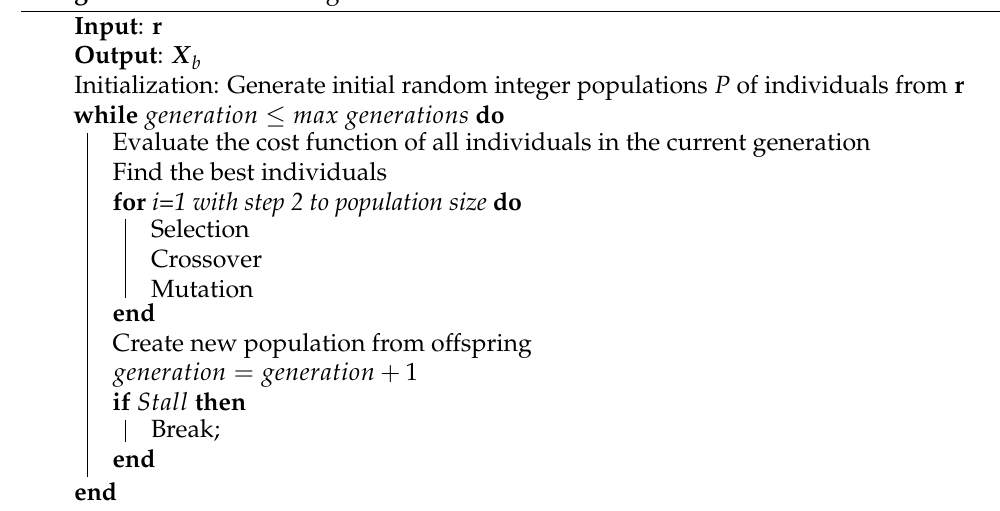
Algorithm 10: Genetic